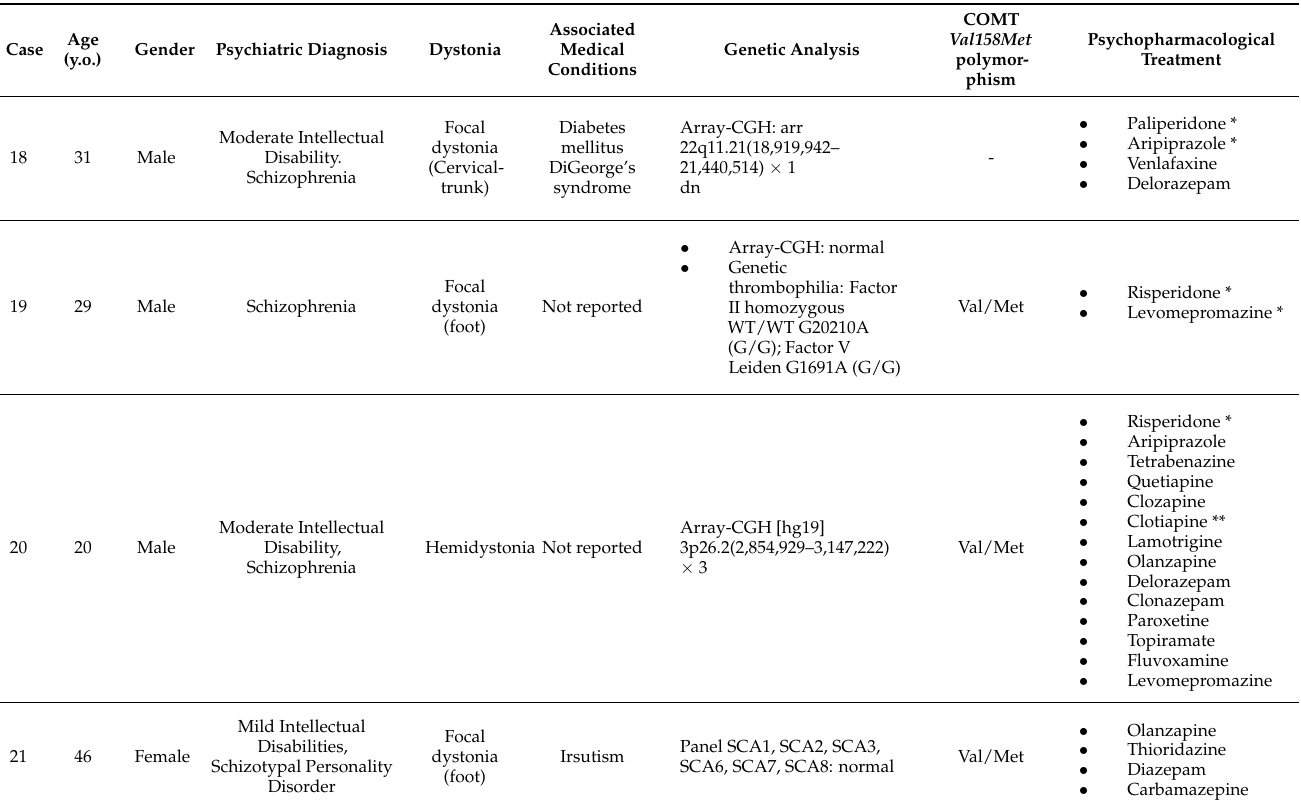
Table 2. Characteristics of APD-sensitive (APDS)